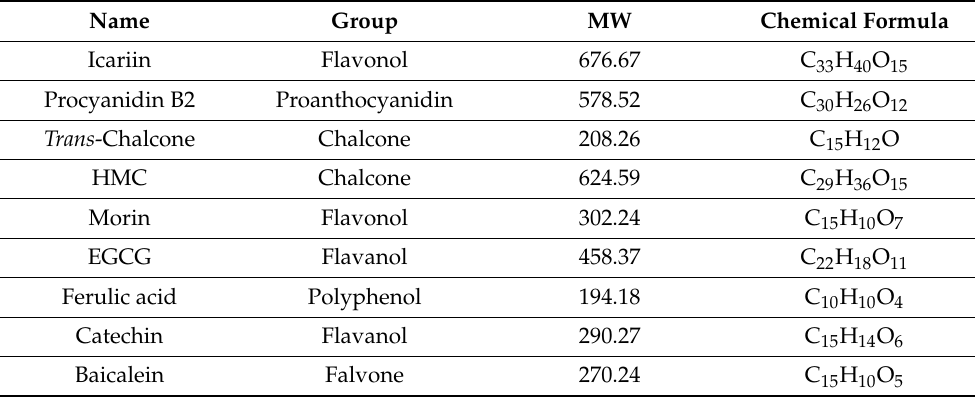
Table 1. The names, groups, molecular weight (MW), and chemical formula of the flavonoids discussed in this study are